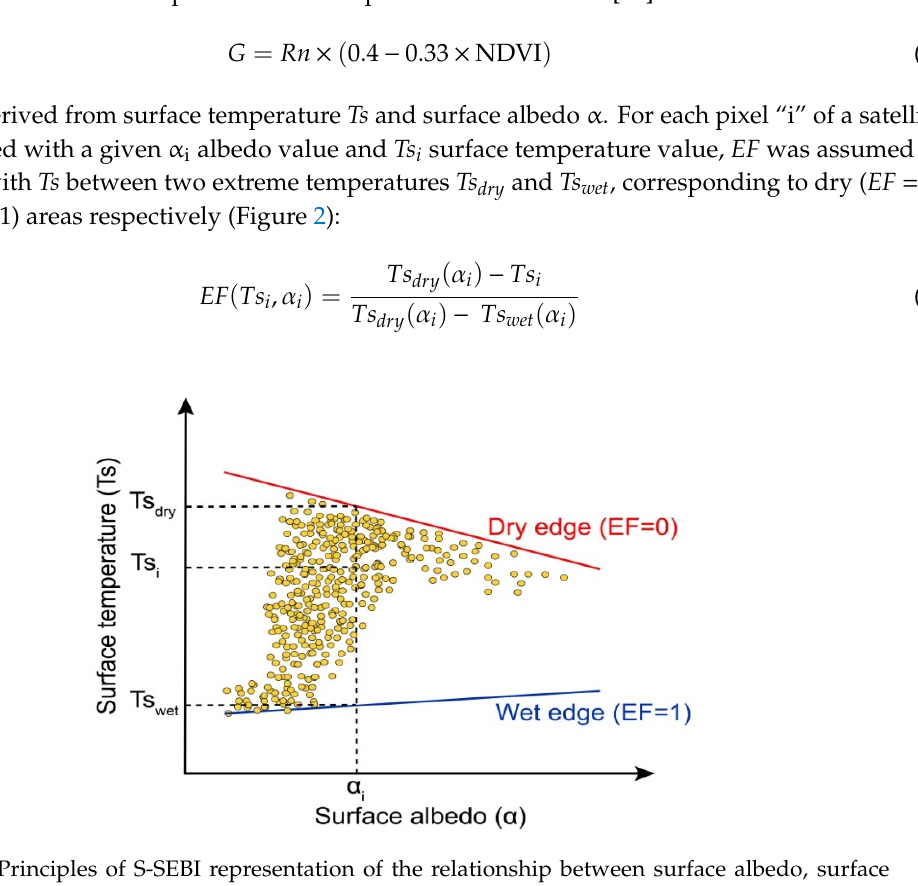
Figure 2. Principles of S-SEBI representation of the relationship between surface albedo, surface temperature, and an evaporative fraction (adapted from Roerinket al.